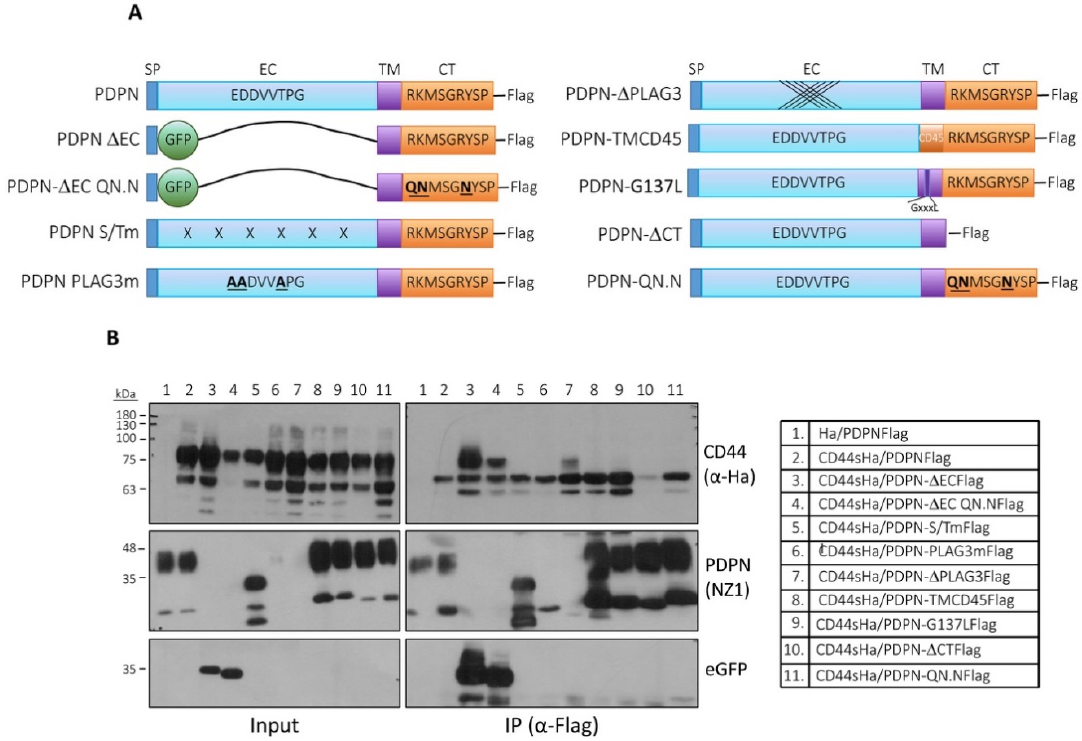
Figure 7. Co-immunoprecipitation of podoplanin mutants with CD44s. ( A ) Schematic representation of podoplanin wild-type and mutant constructs used for co-immunoprecipitation assays. SP—signal